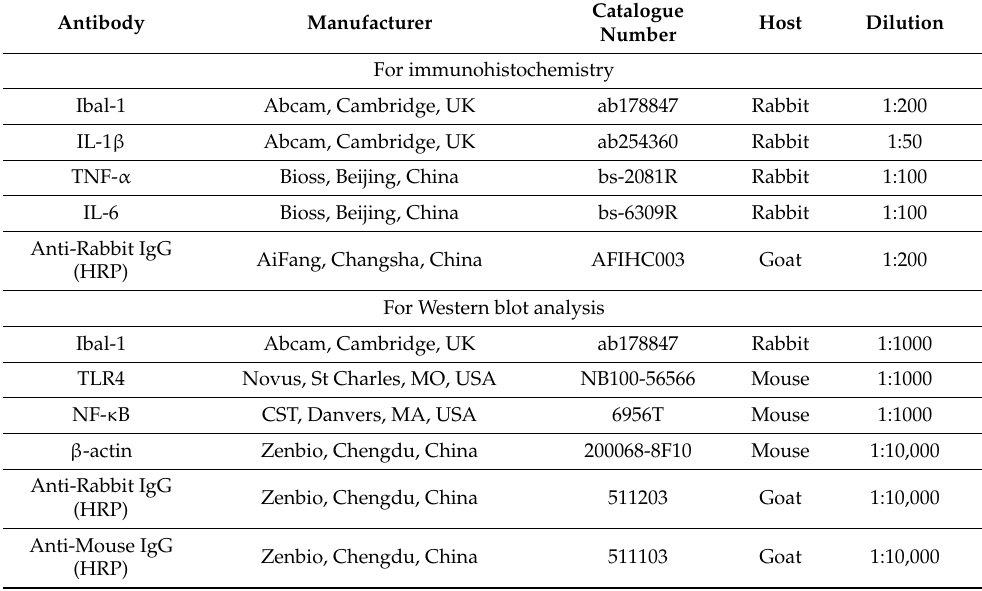
Table 2. Antibodies used in immunohistochemistry and Western blot